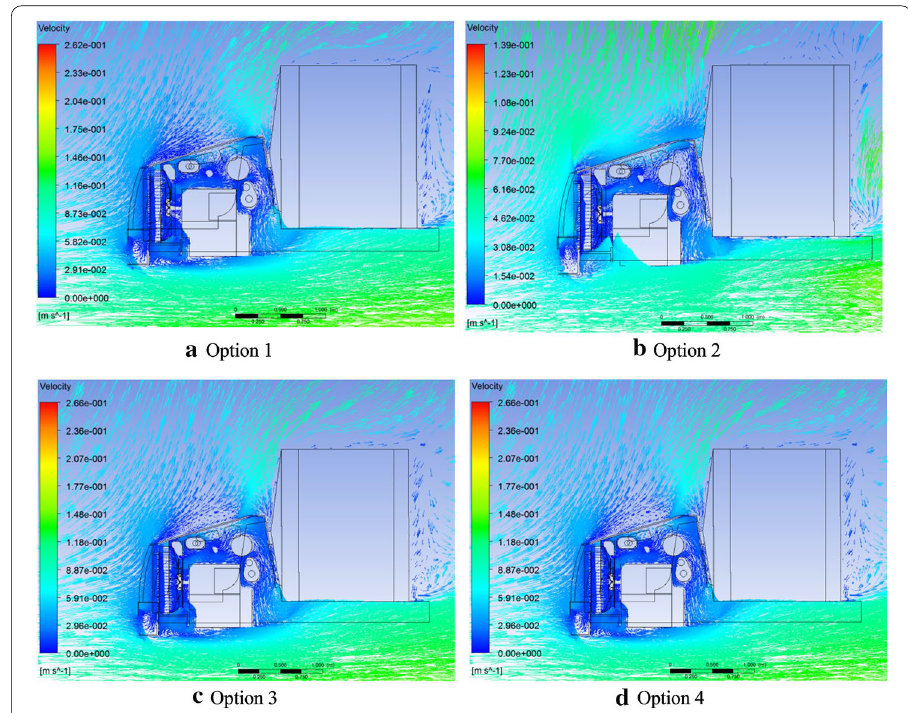
Fig. 5 Cross‑sectional speed vector at idle ( x